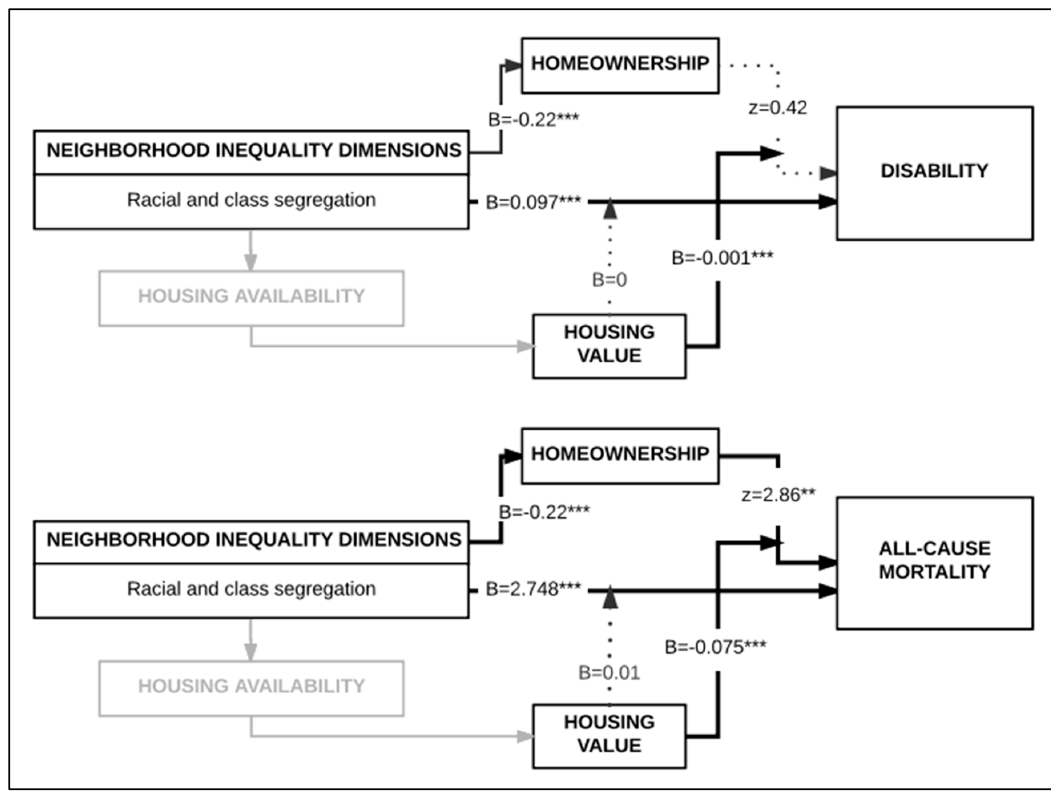
Figure 2. Pathway results examining the relation between neighborhood racial composition, homeownership and housing value for each of the two health outcomes, disability and all ‐ cause mortality. Only tested pathways are illustrated in black. B values are coefficient estimates; z values are Sobel test results; ** p < 0.05; *** p < 0.001.